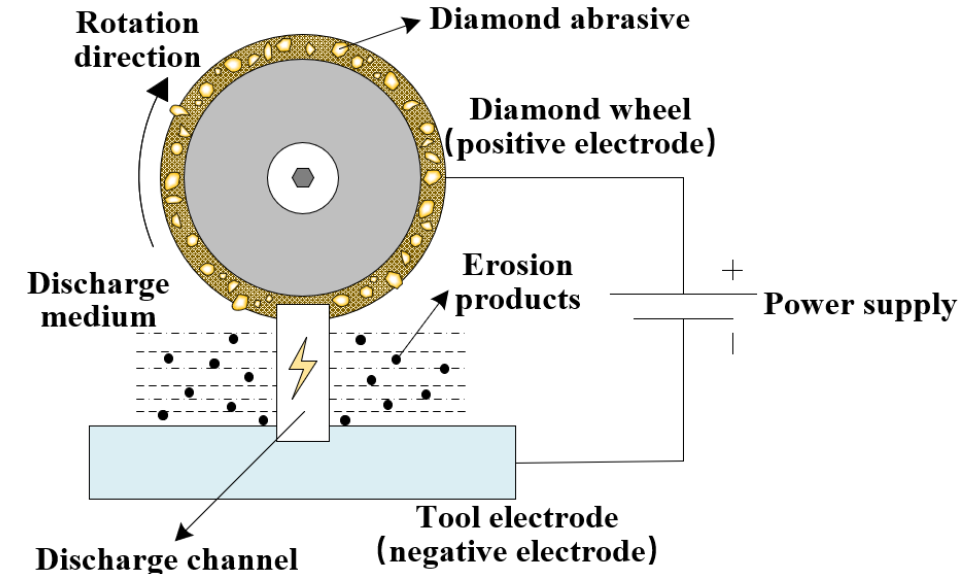
Figure 11. Schematic diagram of electric spark dressing technology.